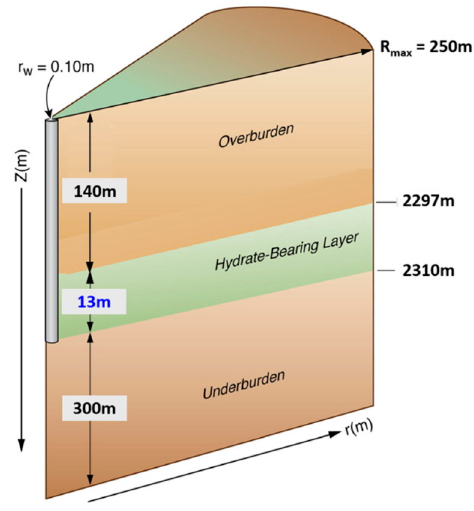
Figure 4. Cylindrical model used in the simulation.